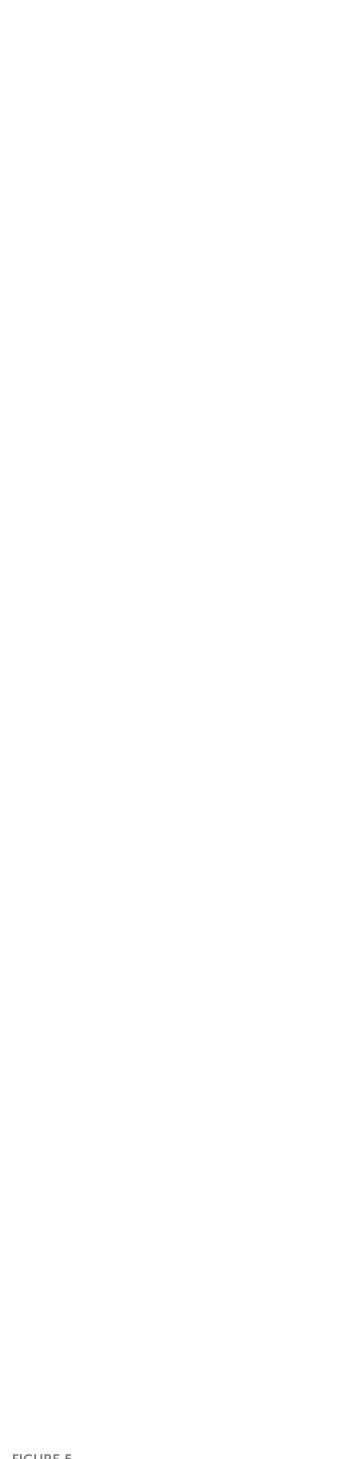
FIGURE 5 Individual patient IEI presentation. A subset of IEI patients with (A) EoE and (B) EGID are represented by IEI category as assigned in the USIDNET and by genetic diagnosis when known. The features are shaded for each patient if the lab values were recorded documenting the following: absolute lymphocyte count (ALC) < 1,500 cells/ m L; absolute eosinophil count (AEC) > 500 cells/ m L; #serum immunoglobulin levels < 700 mg/dL in patients 5 years of age and older or <500 in patients 4 years of age and younger; and serum immunoglobulin E (IgE) > 2,000 IU/mL. * denotes genetic diagnosis